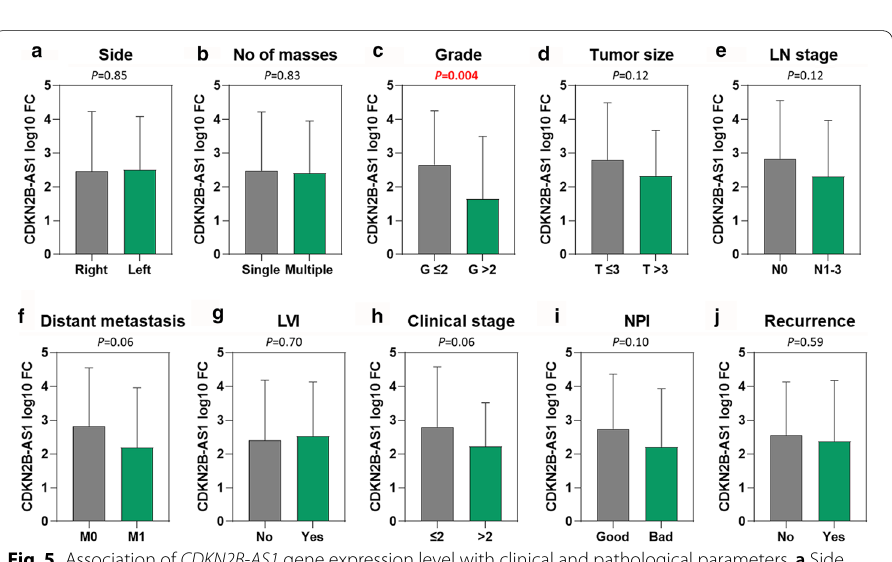
Fig. 5 Association of CDKN2B-AS1 gene expression level with clinical and pathological parameters. a Side of the BC. b Number of BC masses. c BC grade. d BC tumor size. e Lymph node stage. f Distant metastasis. g Lymphovascular infiltration. h Clinical stage of BC patients. i Nottingham prognostic index for BC patients. j Recurrence of BC patients. Fold change was log10 transformed. Student’s t-test was used. P -values below 0.05 were set to be significant. OQ outer quadrant, LN lymph node, LVI lymphovascular infiltration, NPI Nottingham prognostic